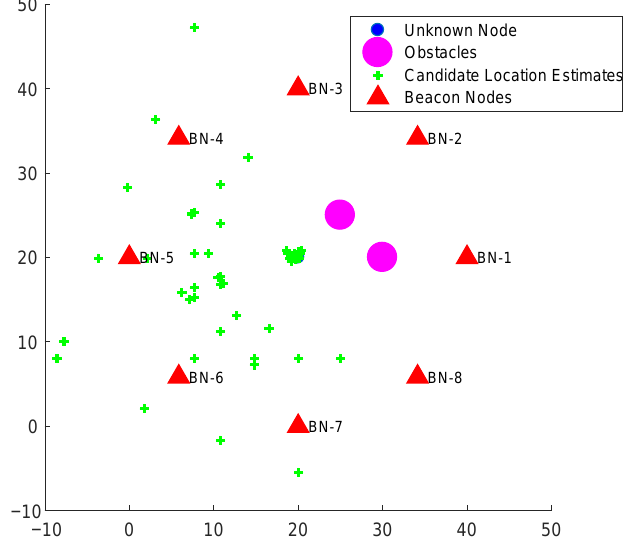
Figure 4. Illustration of the effect of obstacles on candidate location estimates of an unknown node, as obtained from